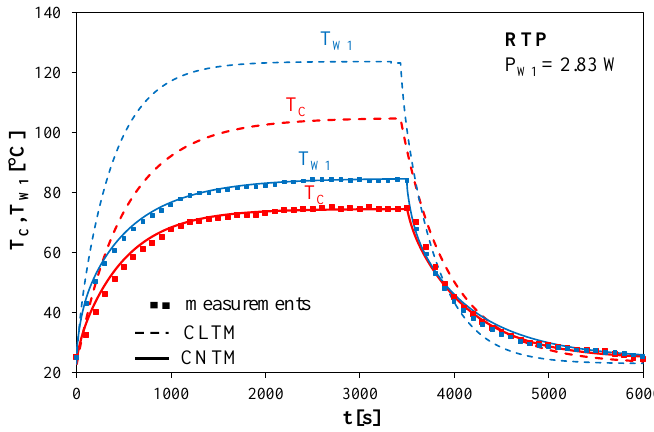
Figure 7. Measured and calculated temperature waveforms of the primary winding T W1 and the core T C of a toroidal transformer with an RTP at a dissipated power P W1 of 2.83 W in the primary winding.